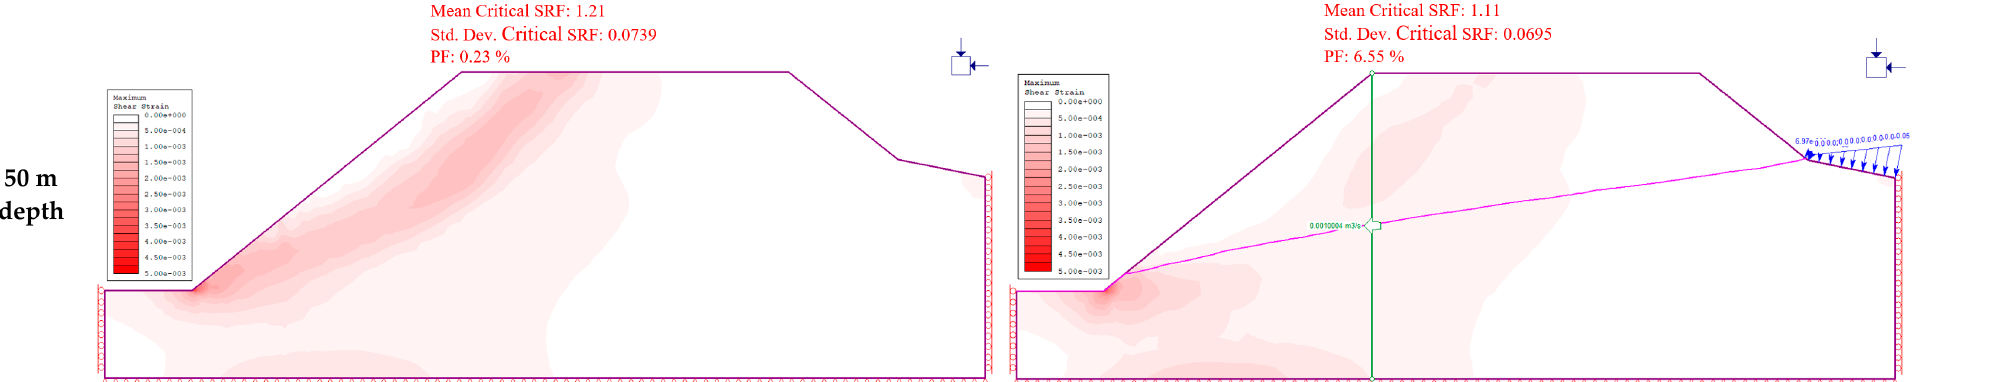
Figure 14. Changes in slope safety factor at 100 m from the shoreline.